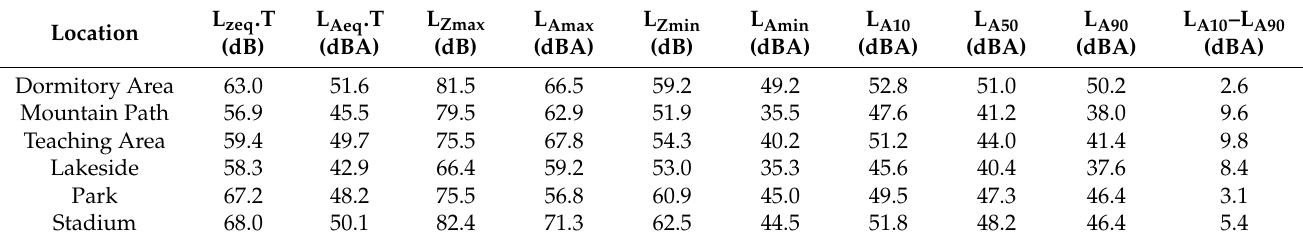
Table 1. Acoustic statistics.